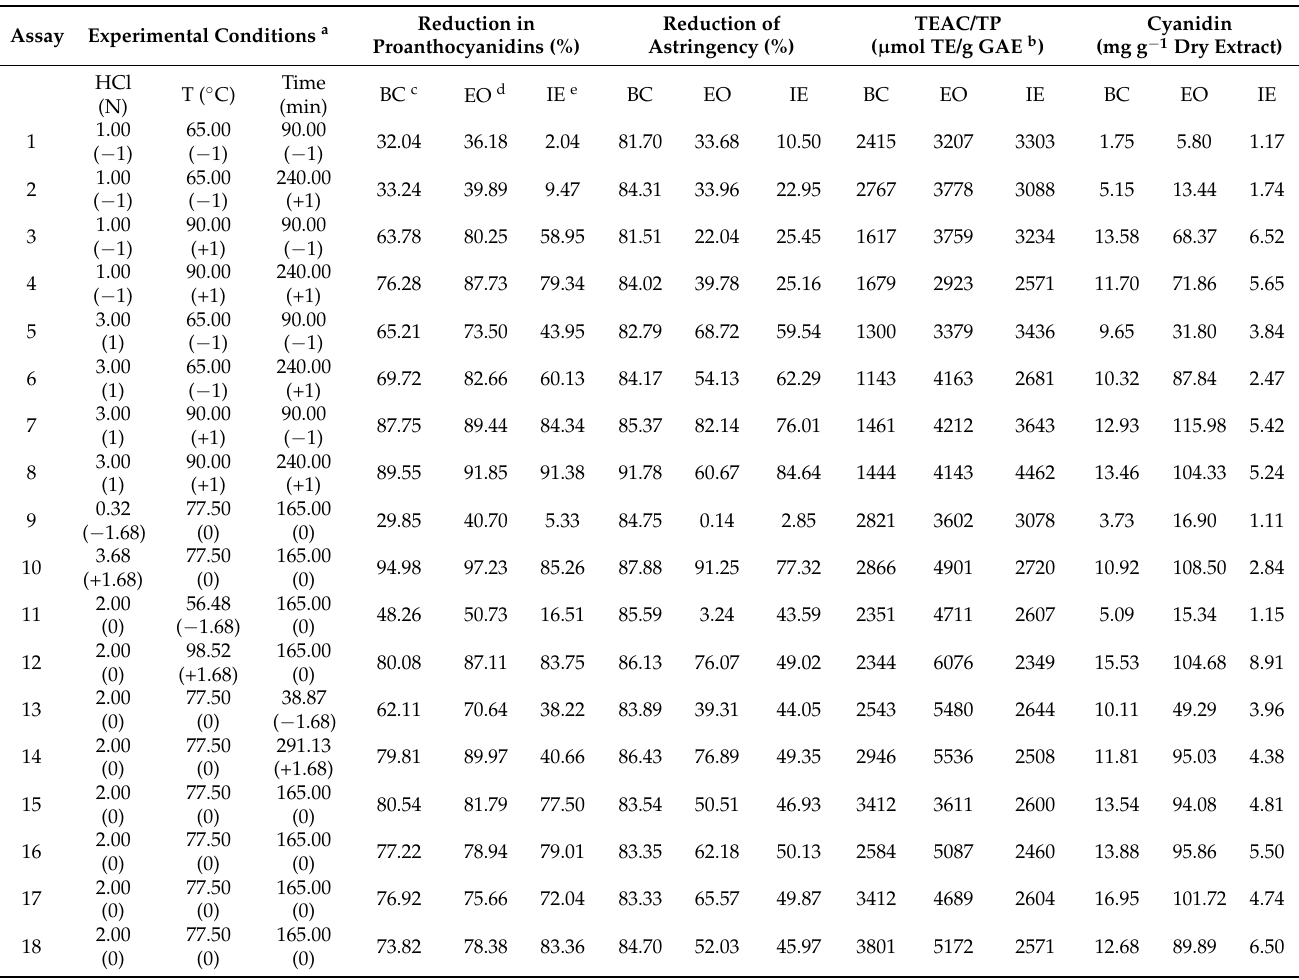
Table 2. Experimental conditions and results of the response variables obtained after the completion of the experimental